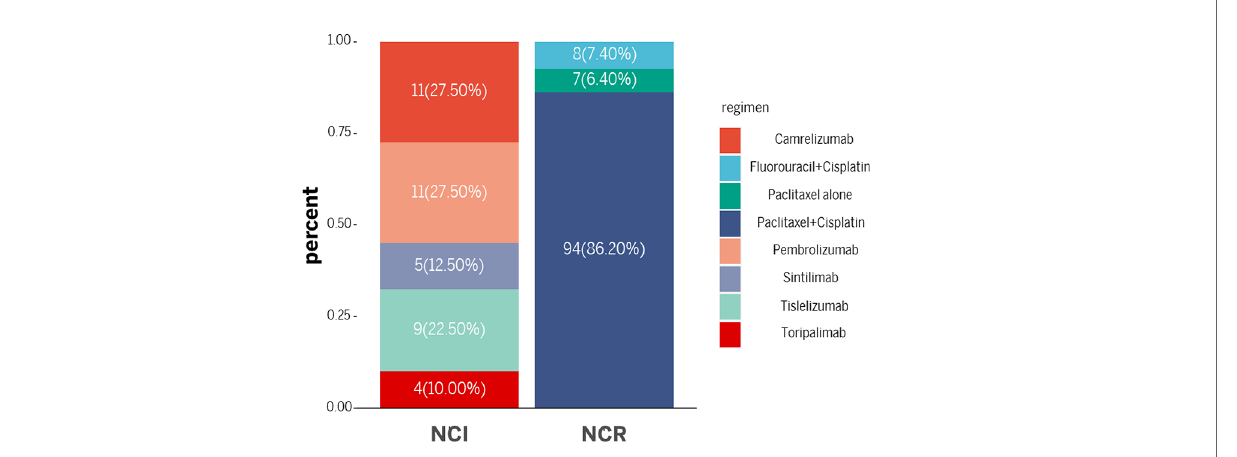
FIGURE 2 | The regimens of neoadjuvant treatments.